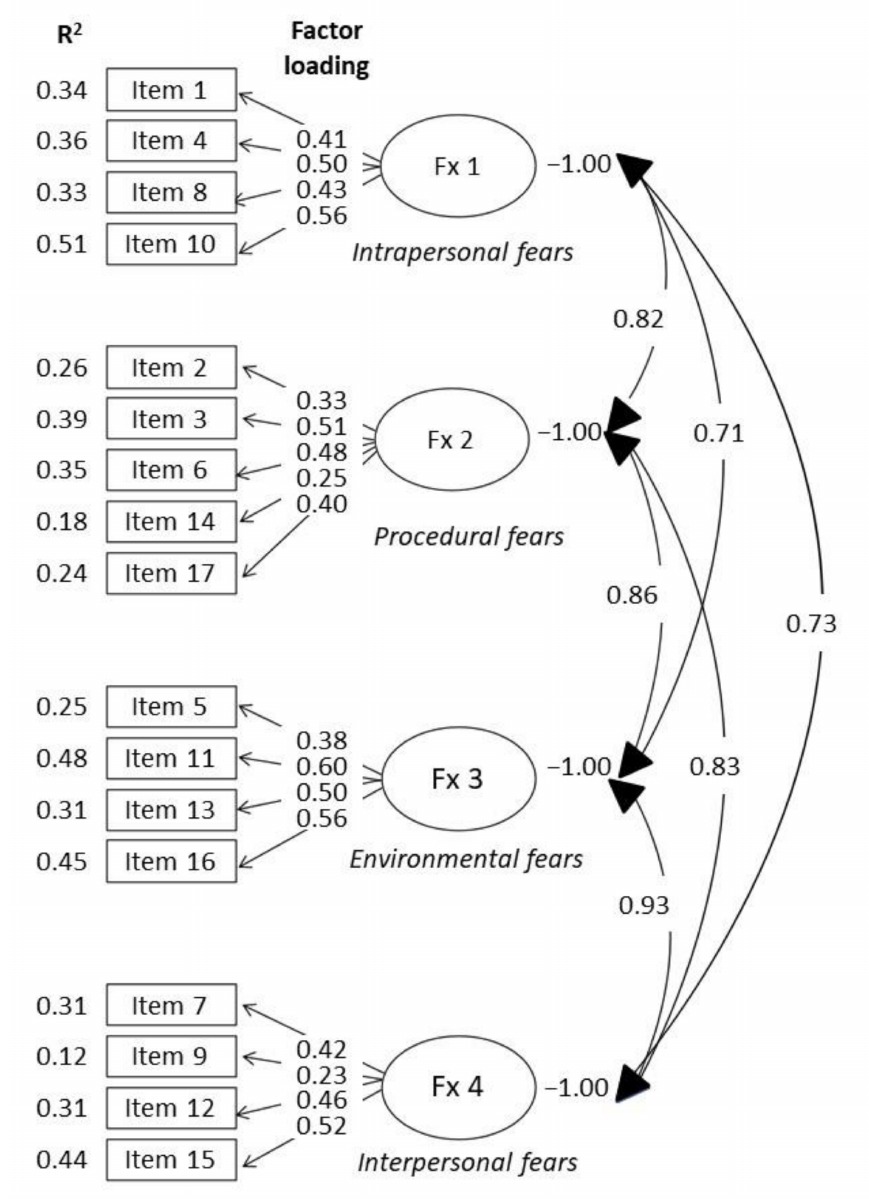
Figure 1. CFA for the 4-factor